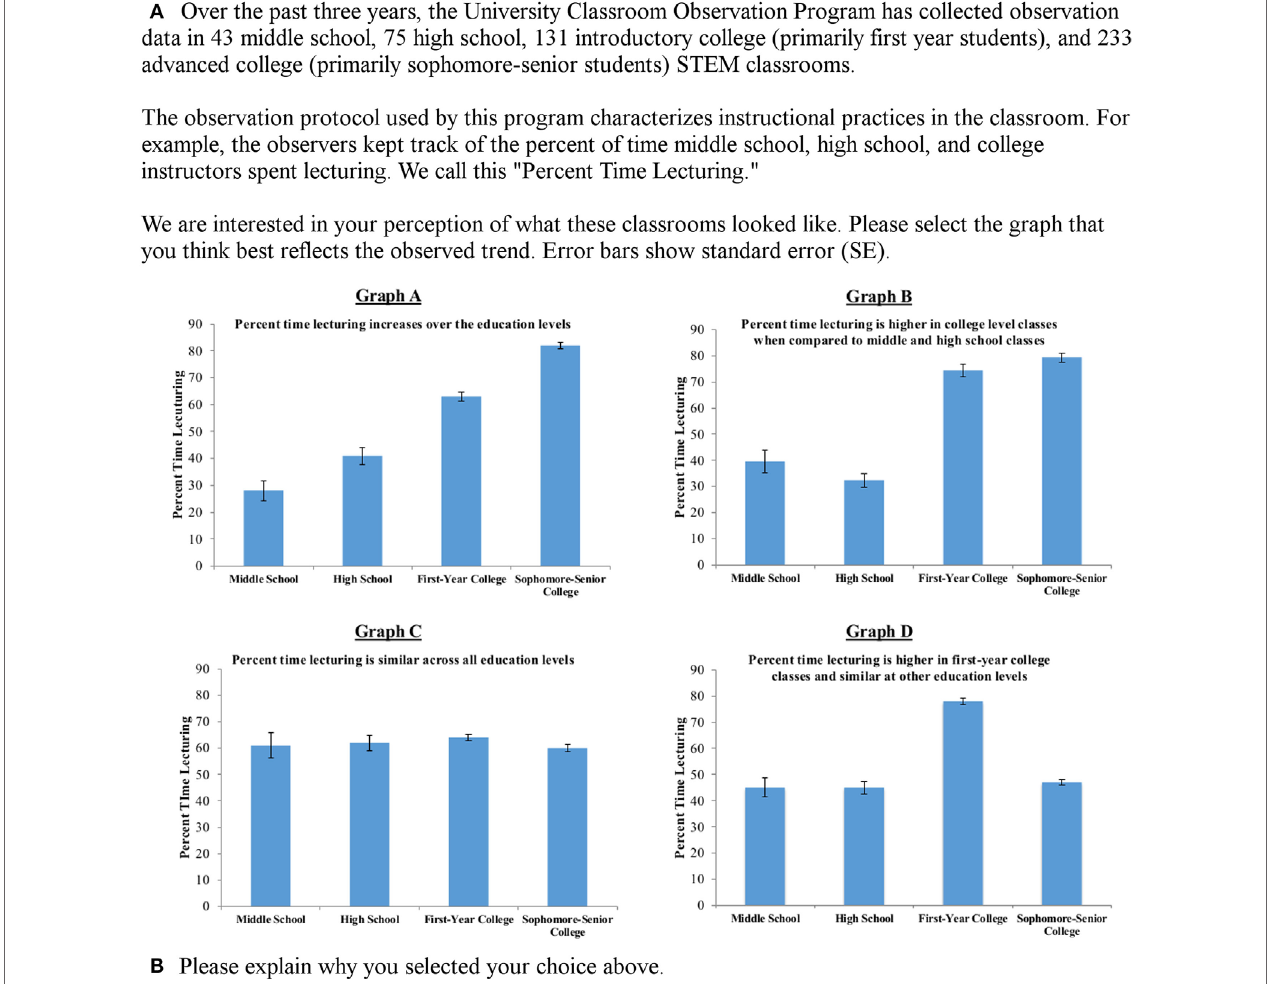
FigUre 12 | Middle school, high school, and university-level instructors were asked to respond to a survey that included (a) a multiple-choice question asking them to predict the Instructor Lecturing code trend we observed with the Classroom Observation Protocol for Undergraduate STEM data and (b) an open-response question where they explained their answer